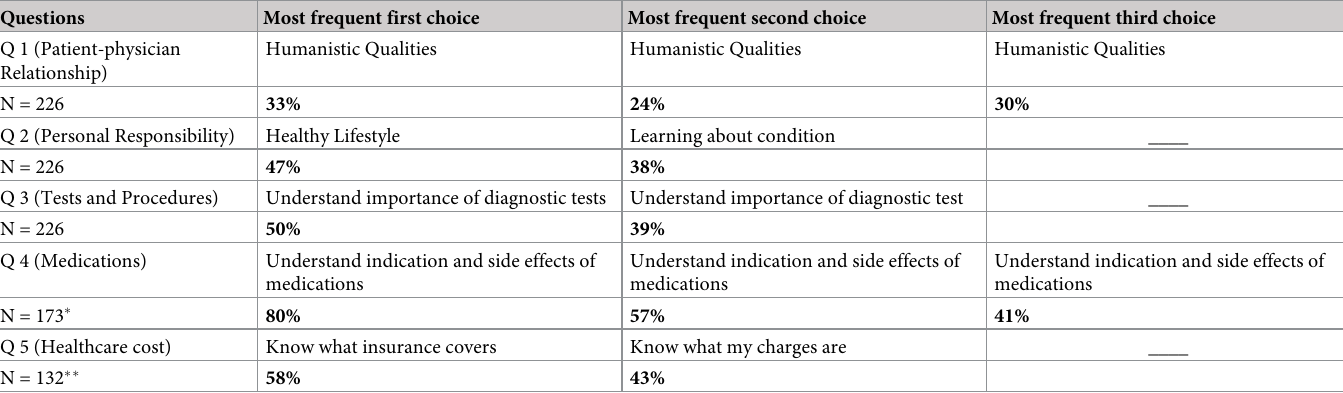
Table 3. Top 1–3 qualities selected by respondents 4 .